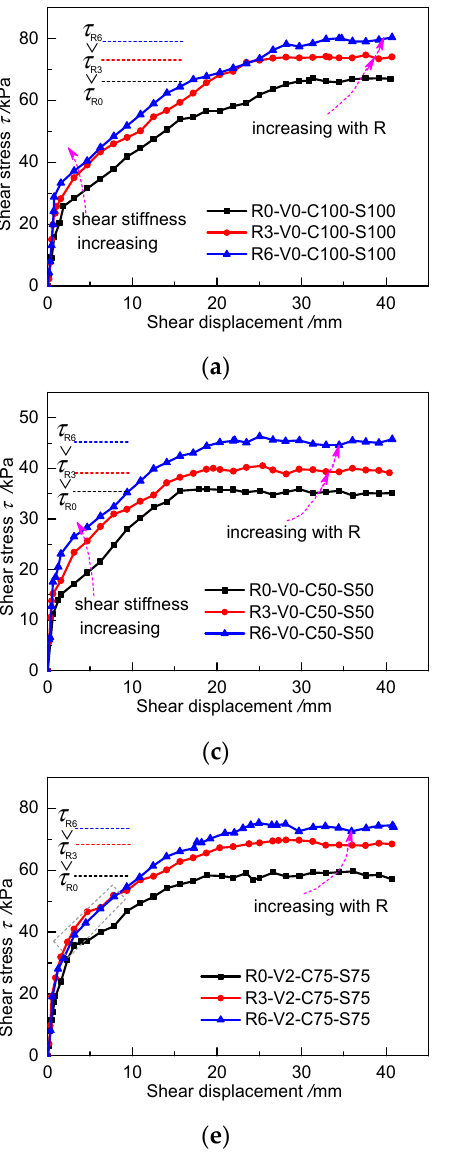
Figure 7. Shear stress–displacement curves ( τ – s curves) for specimens with different roughness values in different cases: ( a ) V0, C100 and S100; ( b ) V0, C75 and S75; ( c ) V0, C50 and S50; ( d ) V2, C100 and